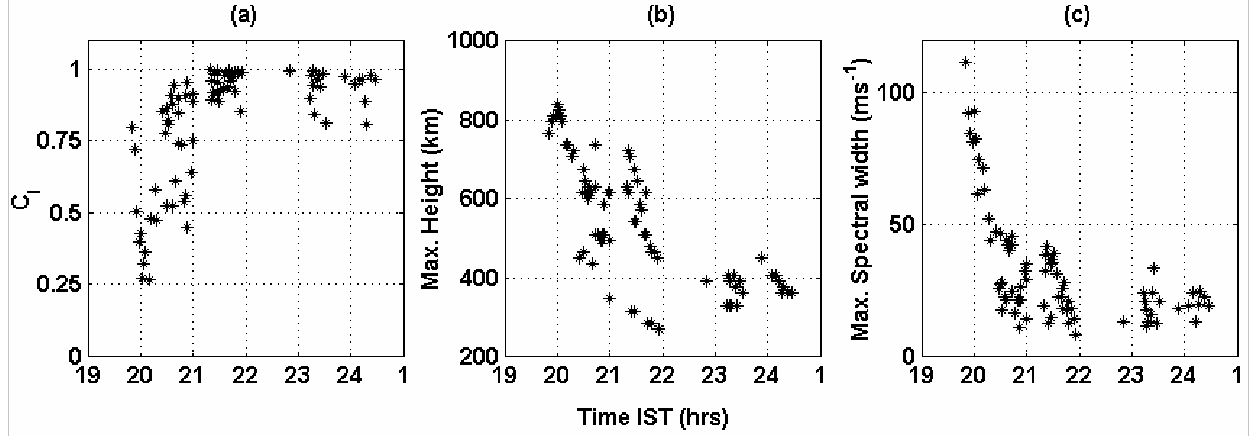
Figure 6ab Fig. 5. Composite scatter plot of temporal variation of (a) C tered echoes.